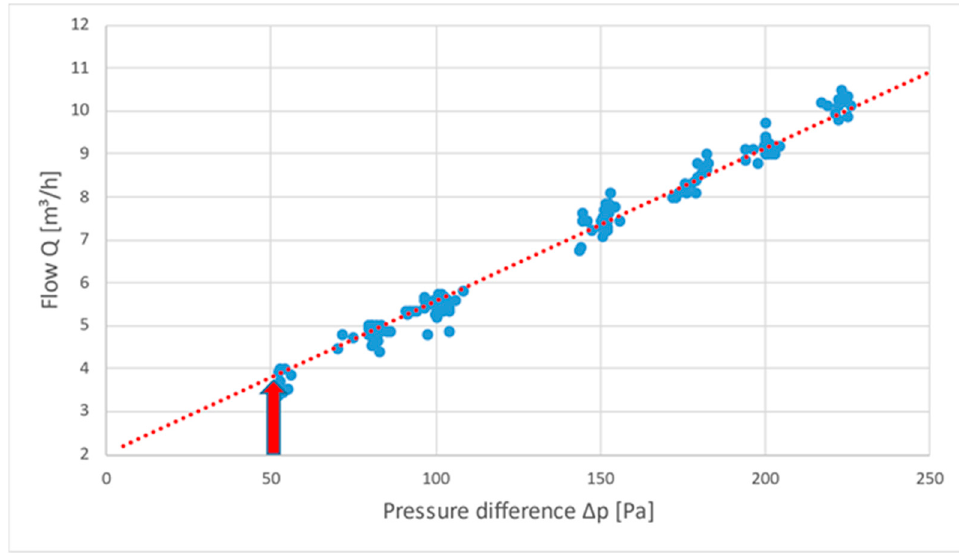
Figure 11. The air permeability during the wet state, 16 February 2022 (probe V2 18.8%); Q 50 = 3.57 m 3 /h, q 50 = 1.47 m 3 /(m 2 .h).